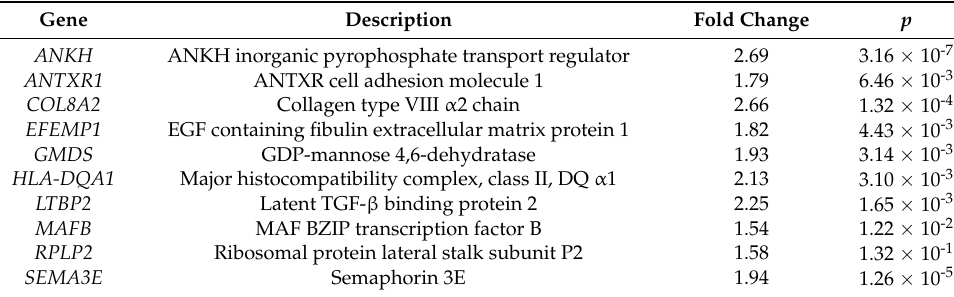
Table 1. Intraocular Pressure-Associated Genes Differentially Expressed in Primary Open-Angle Glaucoma-Affected Human Trabecular Meshwork Tissue.